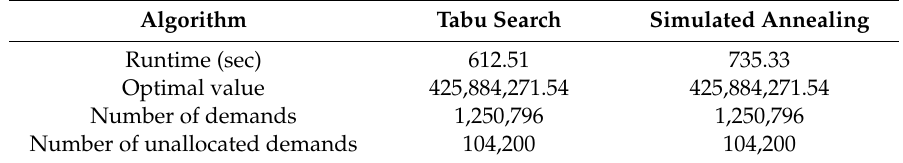
Figure 7. The case study in a larger set. Table 8. Runtime and the optimal value of the VAOMP for existing stations using both algorithms.